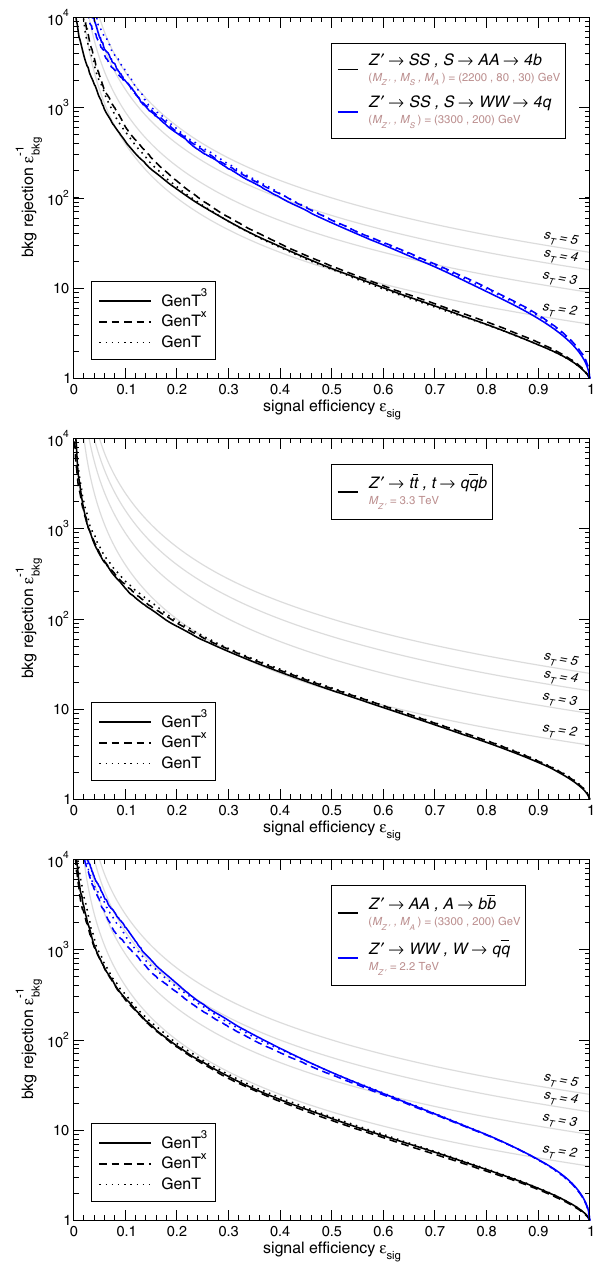
Fig. 1 ROC curves for selected four-pronged (top), three-pronged (middle) and two-pronged (bottom) jet signals